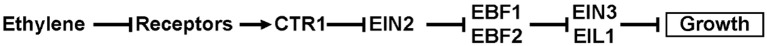
Basic linear ethylene signaling network.